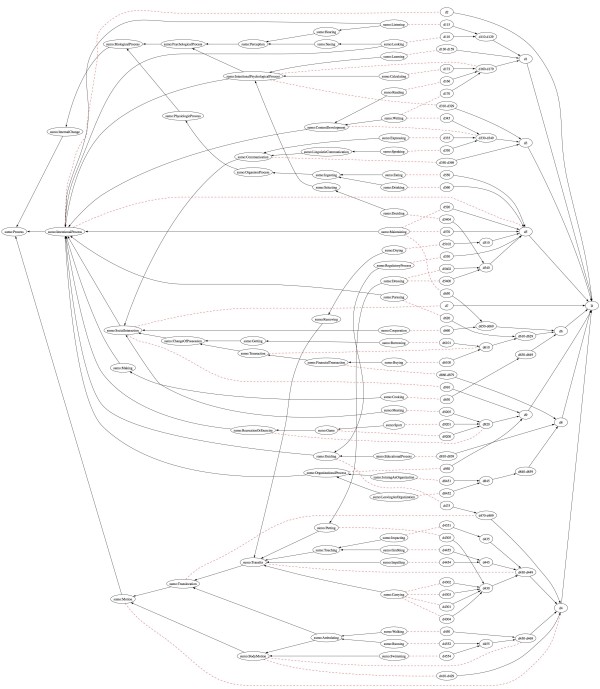
ICF to SUMO mapping.